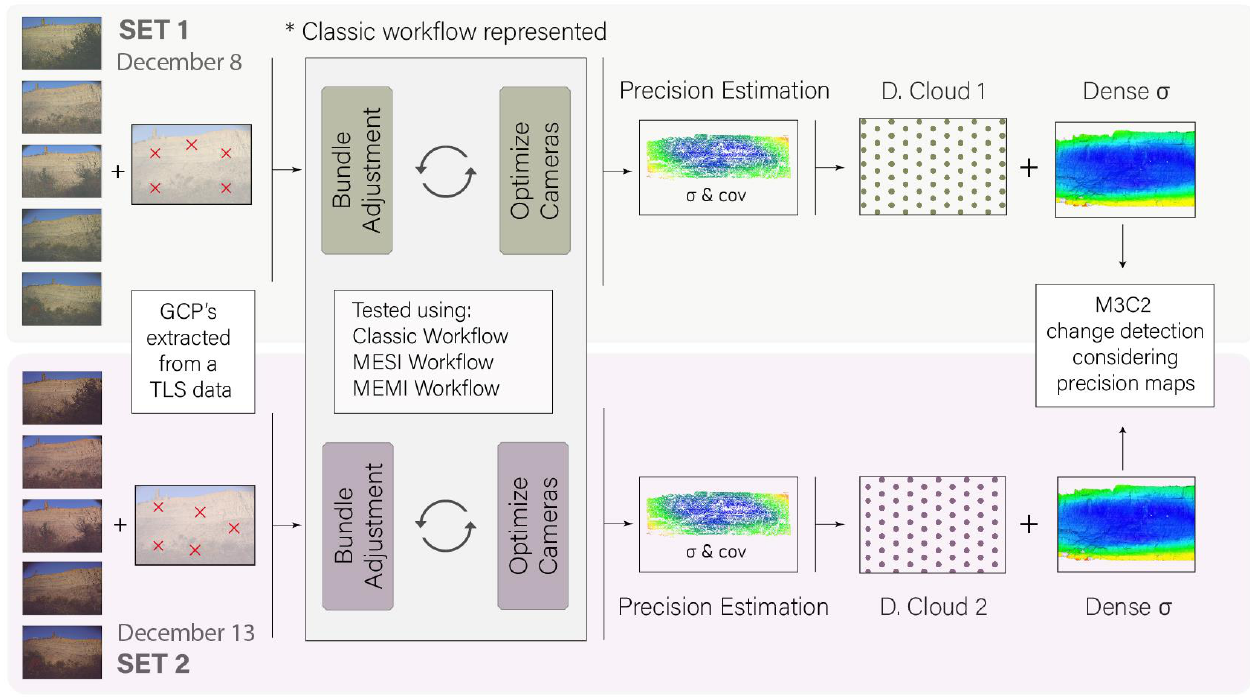
Figure 6. Precision estimation to only detect significant changes. The 4D pipeline illustrated here comprises the classic workflow. The MESI and the MEMI workflow were also evaluated.